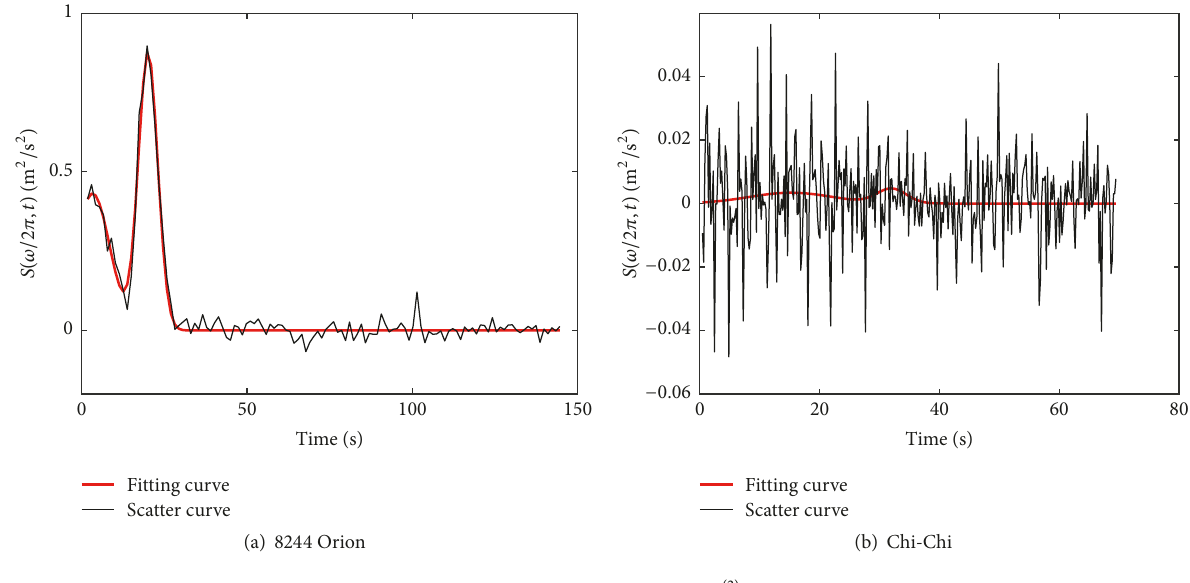
Figure 7: Fitting of parameter 𝑆 (2) 0 (𝑡) .